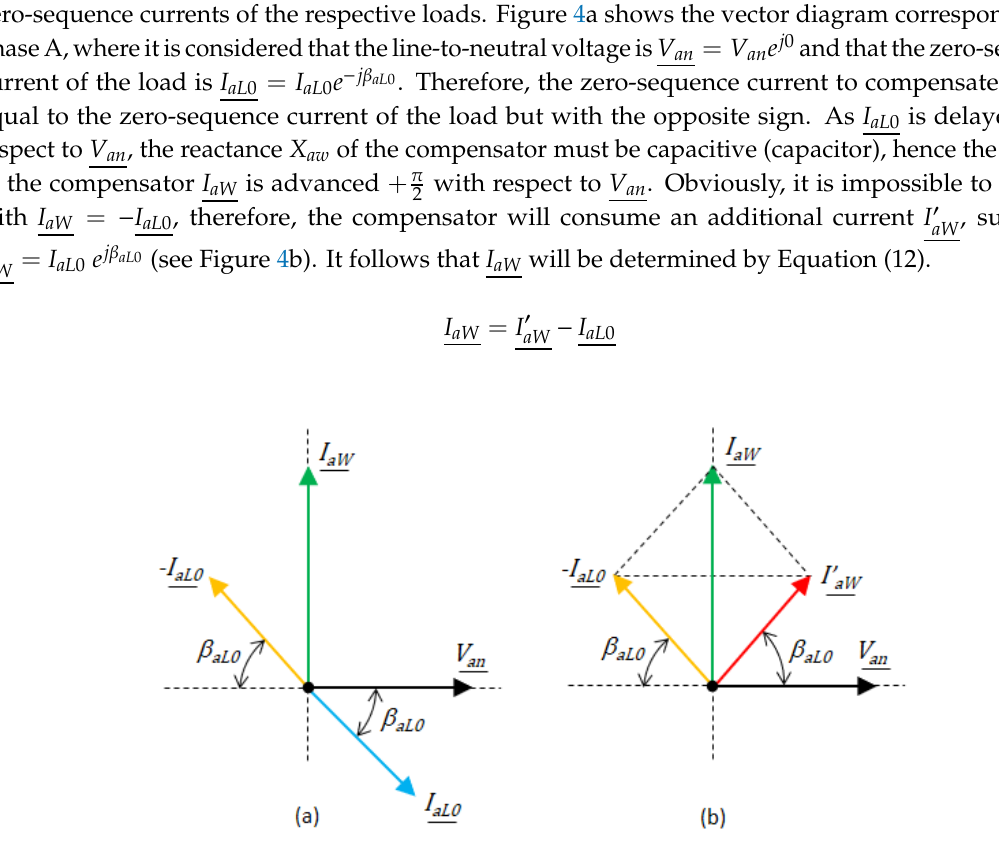
Figure 4. Vector diagram referring to phase A. ( a ) Initial situation and ( b ) Compensated